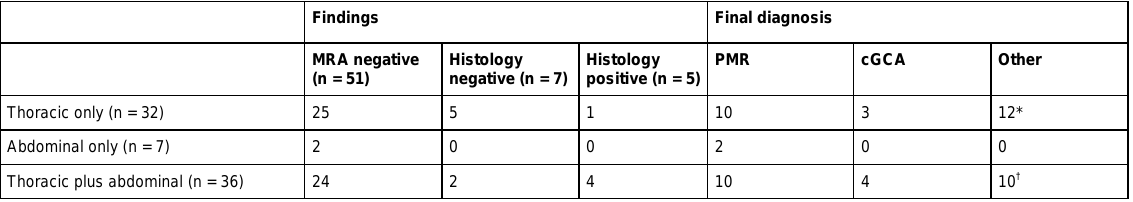
Table 2: Final diagnosis in patients with negative MRA. cGCA = cranial giant-cell arteritis; MRA = magnetic resonance angiography; PMR = polymyalgia rheumatica.